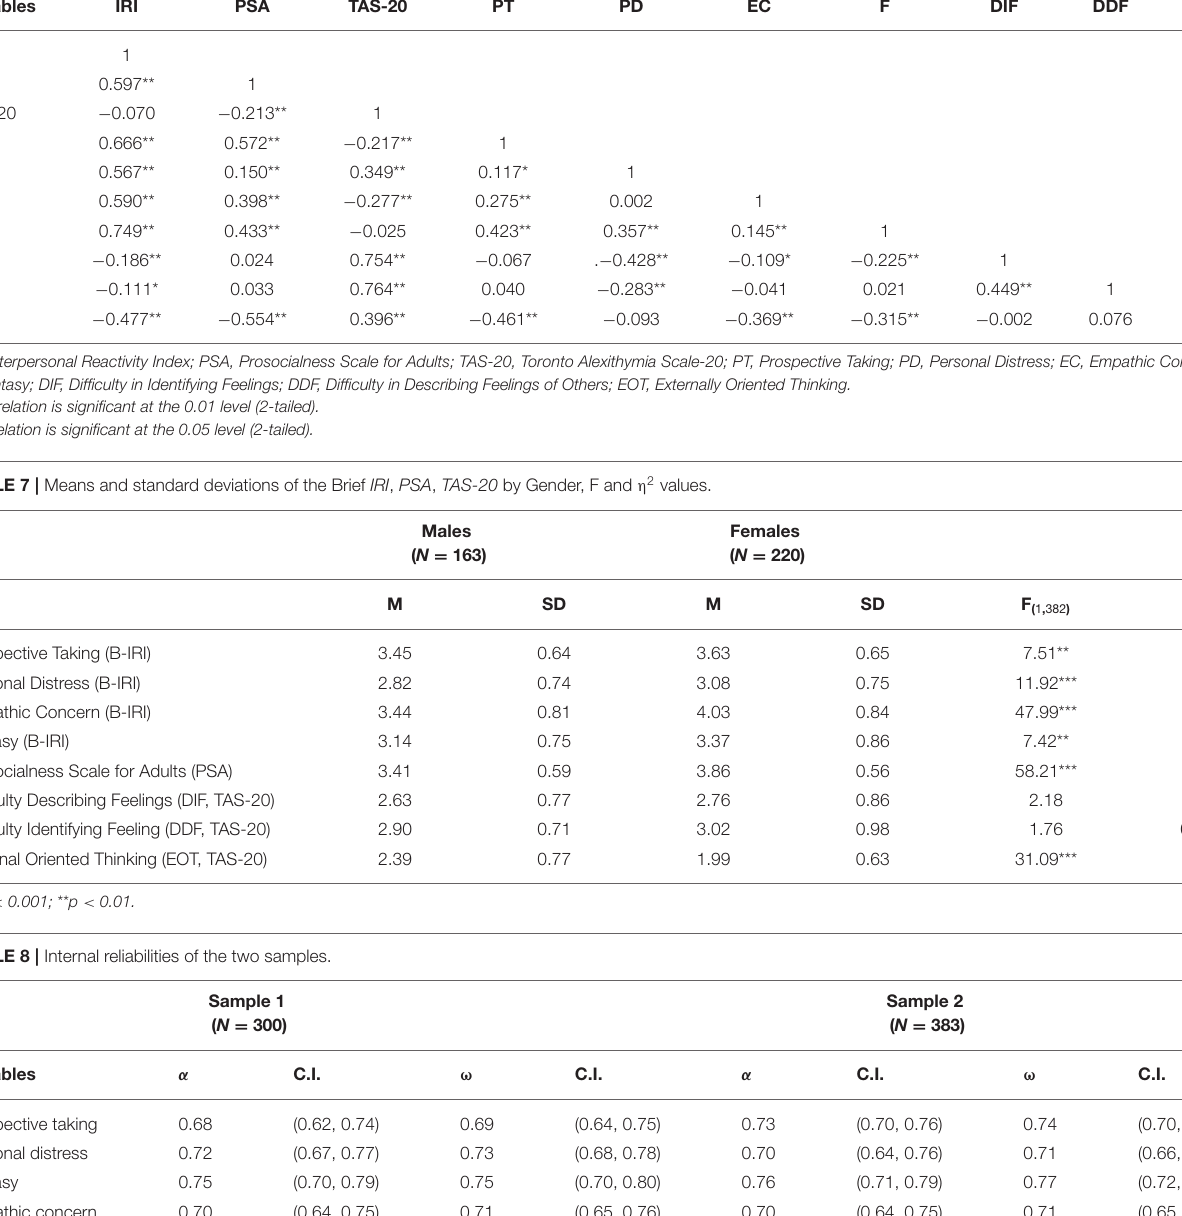
TABLE 6 | Correlations of the interpersonal reactivity index (IRI) with the prosocialness scale for adults [PSA and the toronto alexithymia scale-20 (TAS-20)]. Variables